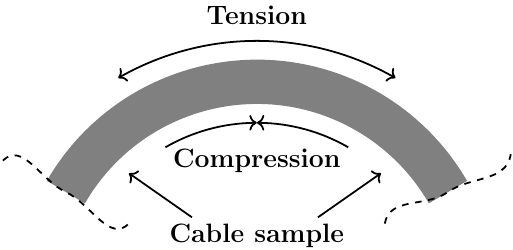
Figure 12. Tension and compression stresses on a bended cable